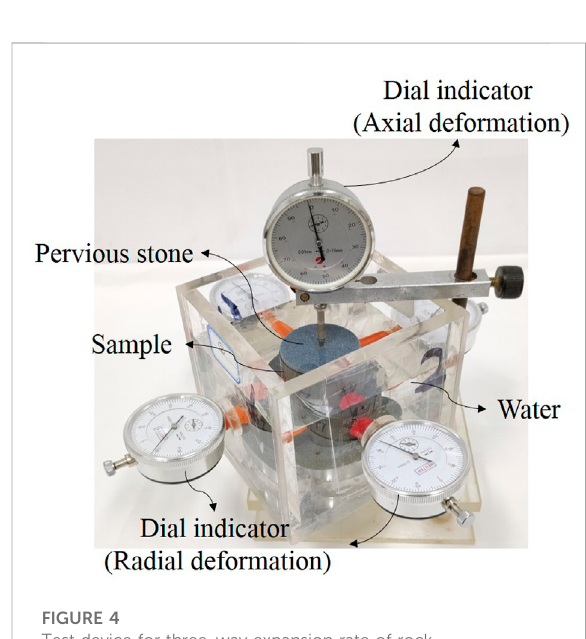
FIGURE 4 Test device for three-way expansion rate of